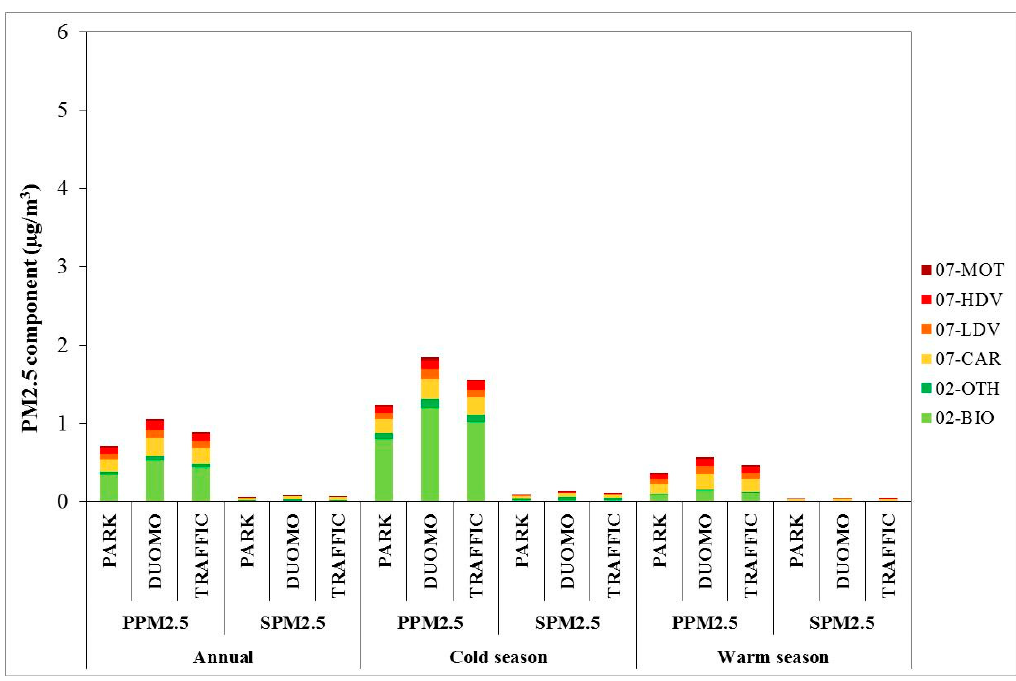
Figure 7. CAMx primary (PPM2.5) and secondary (SPM2.5) PM2.5 levels and source apportionment comparison at the urban receptors (PARK, DUOMO, TRAFFIC) for LOCAL region emissions.